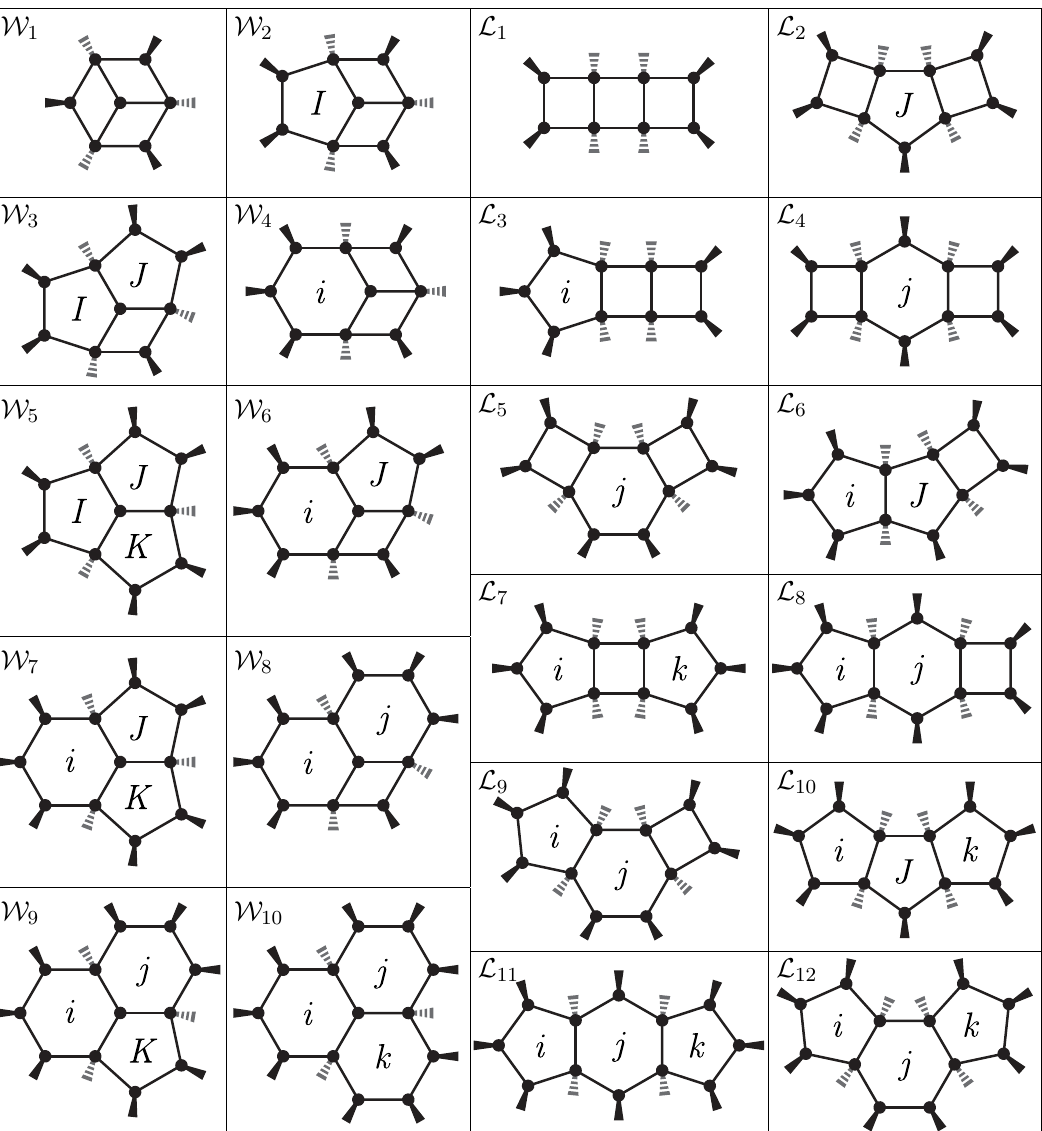
Table 1 . The integral topologies which form a complete basis for three loop amplitudes in planar SYM. Here, f i; j; k g2f 1 ; 2 g and f I; J; K g2f 1 ; 2 ; 3 g label non-contact degrees of freedom for general numerators, explicitly matching the on-shell functions in appendix A.